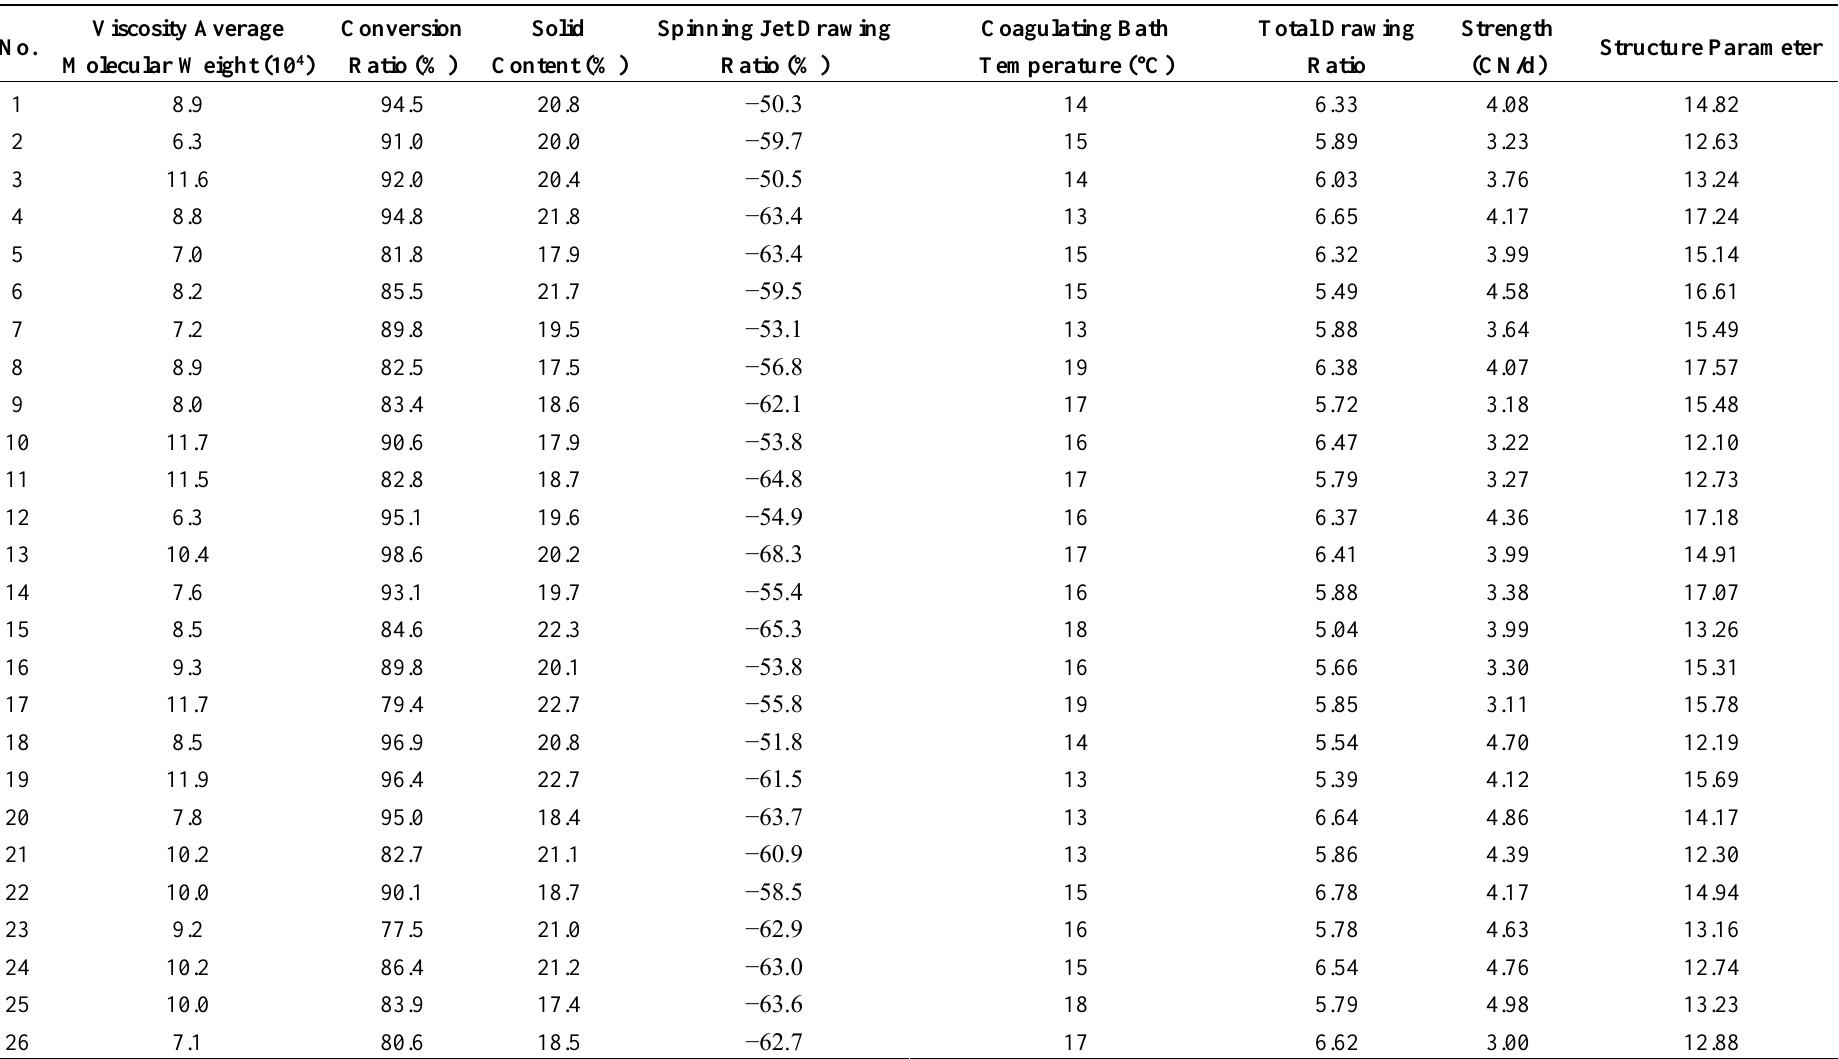
Table 1. Experimental data of carbon fiber in the productive